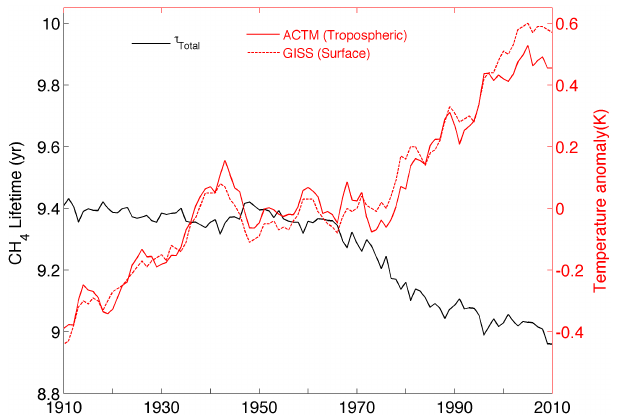
Figure 3. Five-year running means of CH 4 total lifetime and global tropospheric temperature anomaly (with the base period 1951– 1980) during 1910–2010.